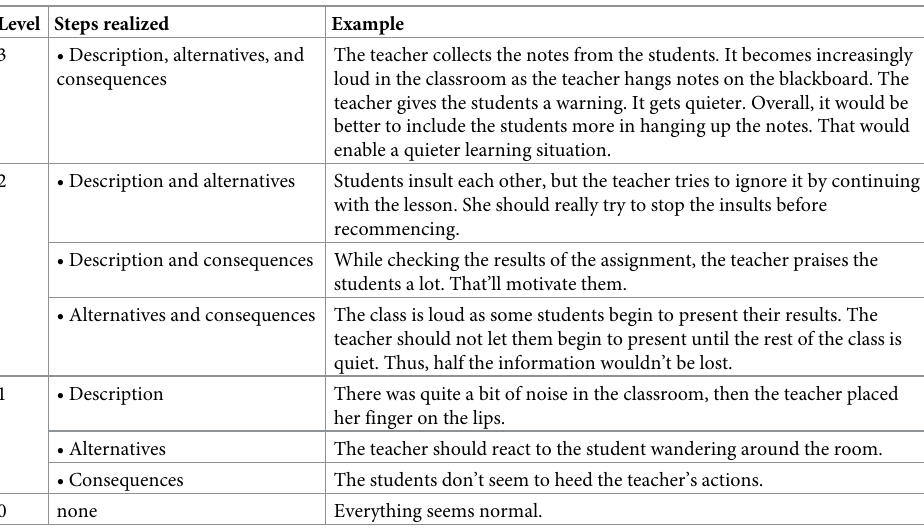
Table 2. Levels of reflective thought based on coded inquiry